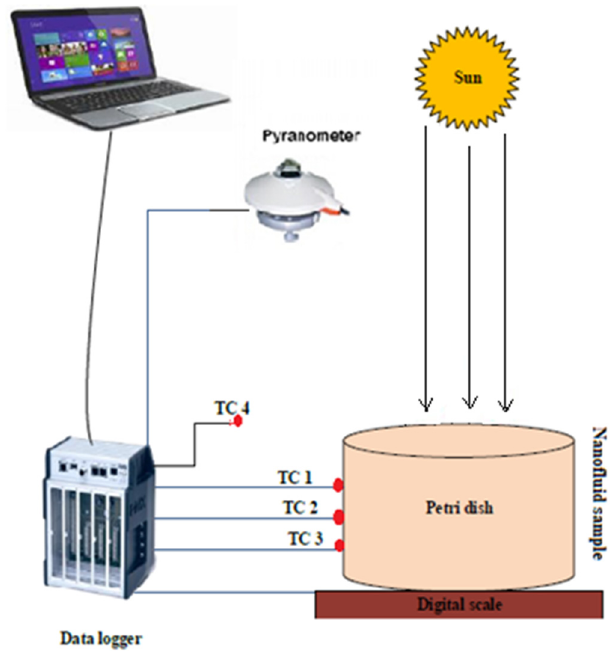
Figure 1. Schematic diagram of the setup used in the experiments under natural sun. TC, thermocouple.